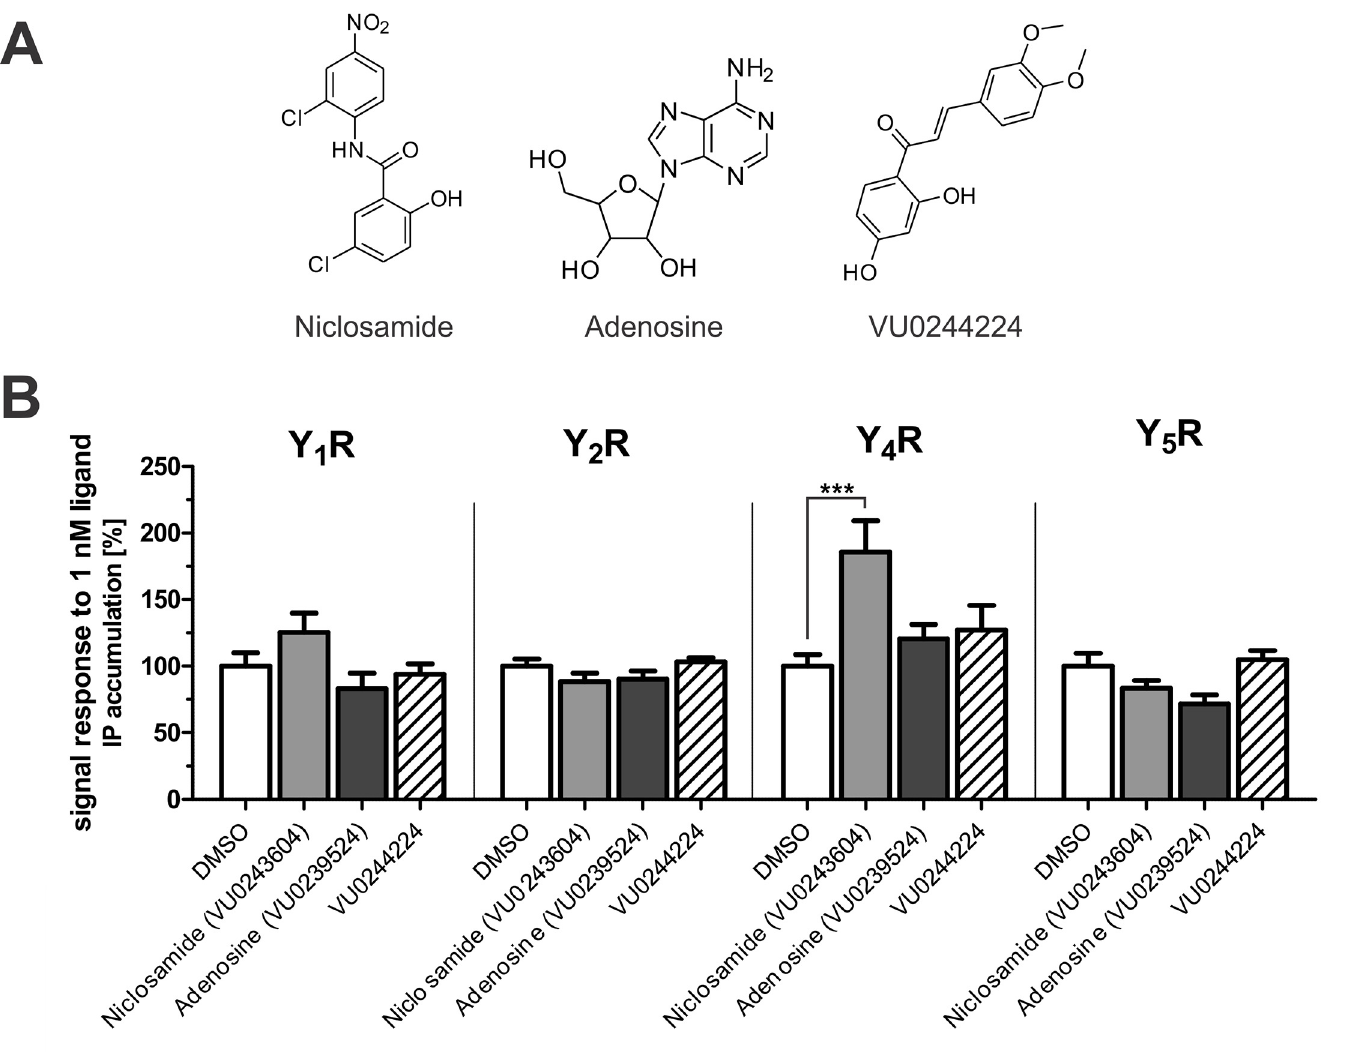
Fig 1. Validation of Y 4 R PAM activity and subtype selectivity of initial Ca 2+ -flux-based screen hit compounds in an inositol phosphate accumulation assay. (A) Compound structures. (B) Effect of10 μ M compound onsubmaximal YR activation by 1 nM ligand,which represents EC 20 -EC 60 (Y 1,2,5 R: NPY; Y 4 R: PP). Data represent themean ± SEM of two independentexperiments each performed inquadruplicate ( *** p (cid:3) .001